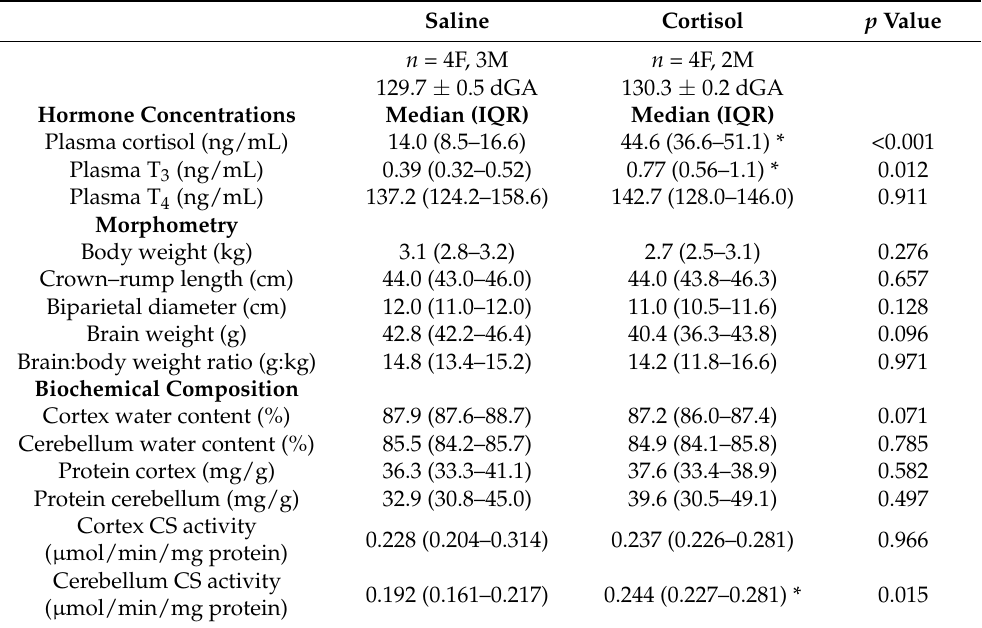
Table 1. Fetal hormonal and biometric measurements. Data are presented as median (interquartile range, IQR, 25th–75th percentile) from saline ( n = 7) and cortisol-infused ( n = 6) fetuses at ~130 days of gestational age (dGA). * Significantly different from saline control, p < 0.05, Mann–Whitney nonparametric test (for biparietal diameter) or t -test (remaining